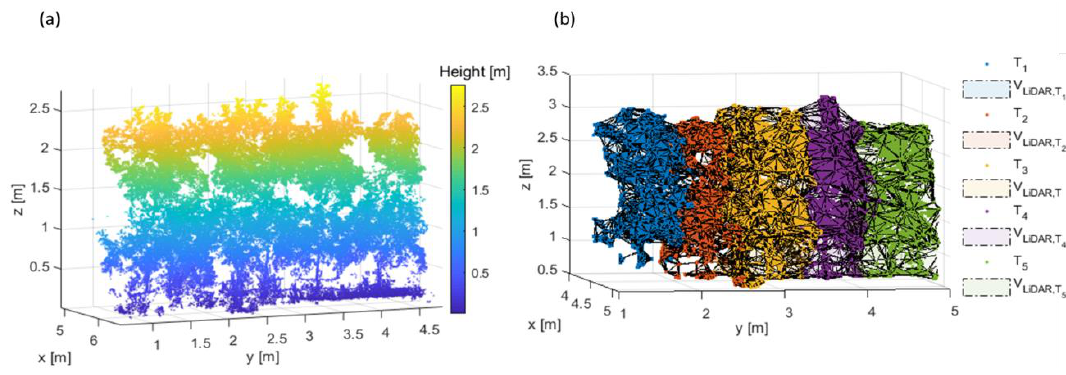
Figure 9. ( a ) Point cloud of four example apple trees and ( b ) visualization of convex hull method showing the canopy volume (V LiDAR,T ) of singularized tree (T n ).